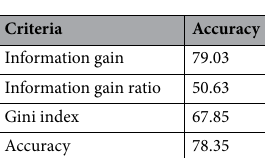
Table 3. Comparison of classification accuracy of constructed Decision Tree (DT) models using different